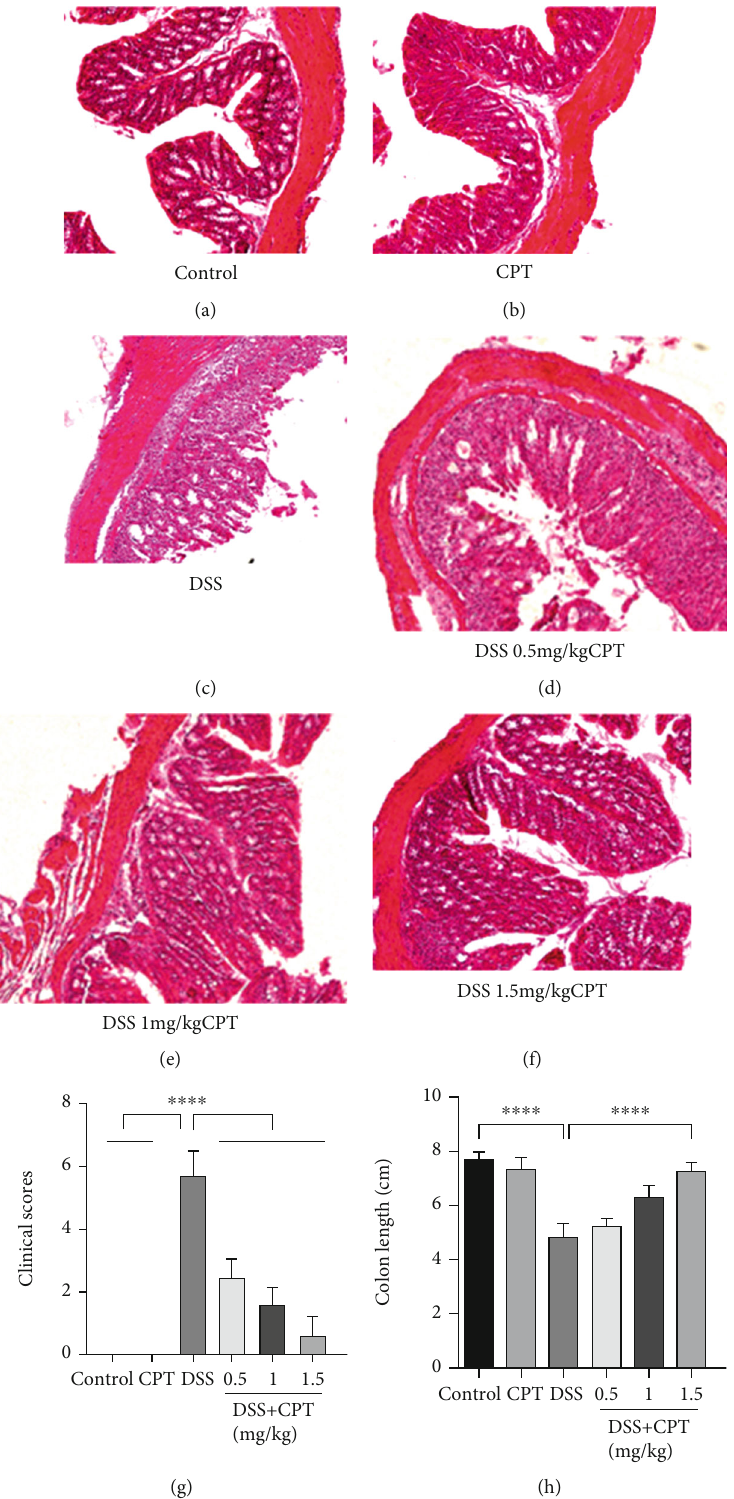
Figure 2: E ff ects of camptothecin (CPT) on the pathological injury of colon tissues in mice with DSS-induced ulcerative colitis (UC). Colon tissue samples were collected from the (a) control group, (b) CPT (1.5 mg/kg) group, (c) DSS group, (d) DSS+CPT (0.5 mg/kg) group, (e) DSS+CPT (1.0mg/kg) group, and (f) DSS+CPT (1.5 mg/kg) group and stained with H&E. (g) Disease activity index and (h) colon length of the di ff erent groups. The mean disease activity index of colon tissues was determined according to a previously described three-point scale. Values are presented as means ± SD ( ∗∗ P < 0 : 01 and ∗∗∗∗ P < 0 : 0001 vs. the DSS